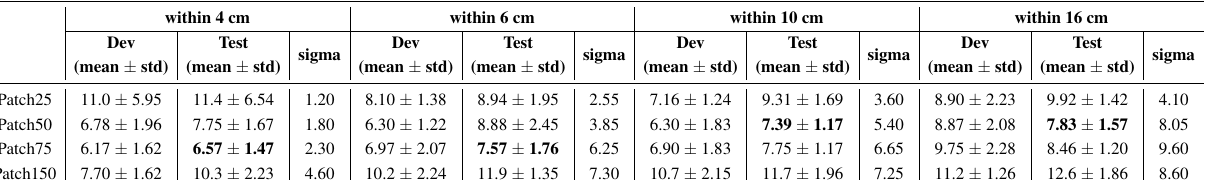
Table A10. HTERs (%) of GLOH features (no overlap, PCA 98%).